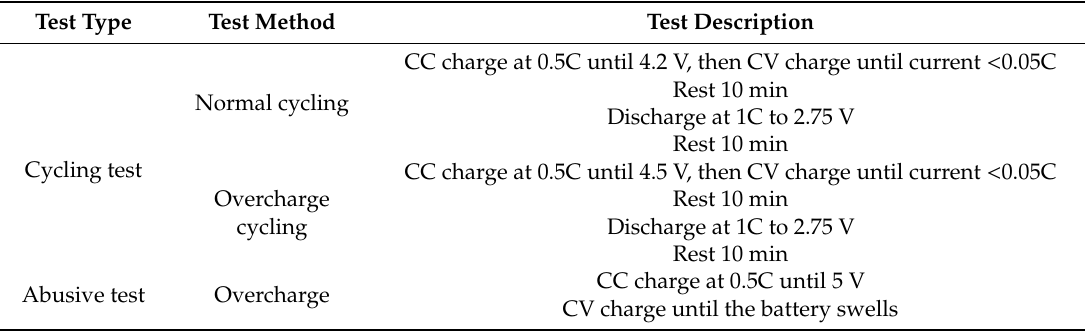
Table 1. Battery test